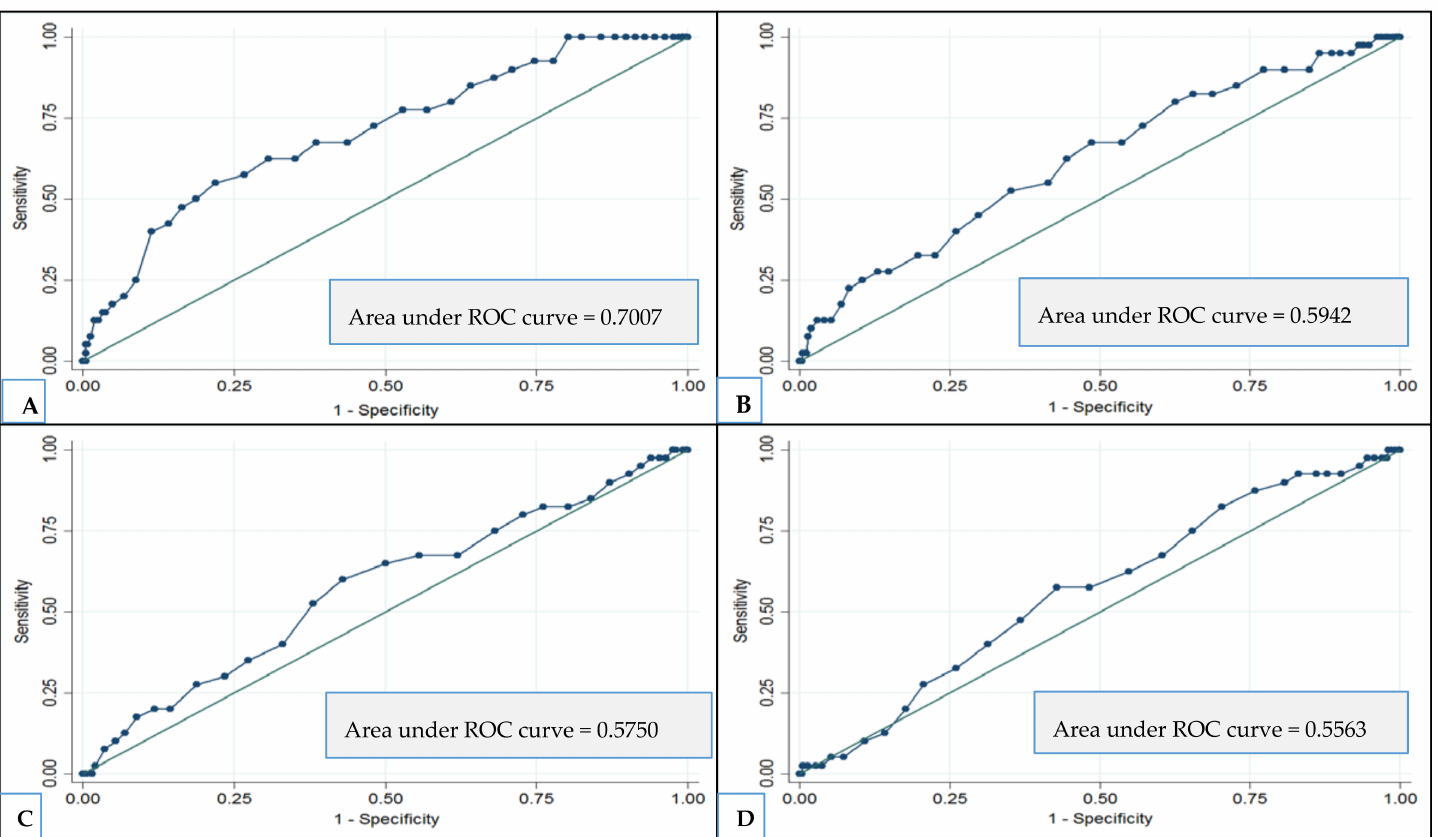
Figure 2. The ability (ROC curve) of each dietary index to correctly predict MMSE decline to ≤ 24 over 6 years. ( A ) Nordic Prudent Dietary Pattern index; ( B ) MIND index; ( C ) Mediterranean Diet index; ( D ) Baltic Sea Diet